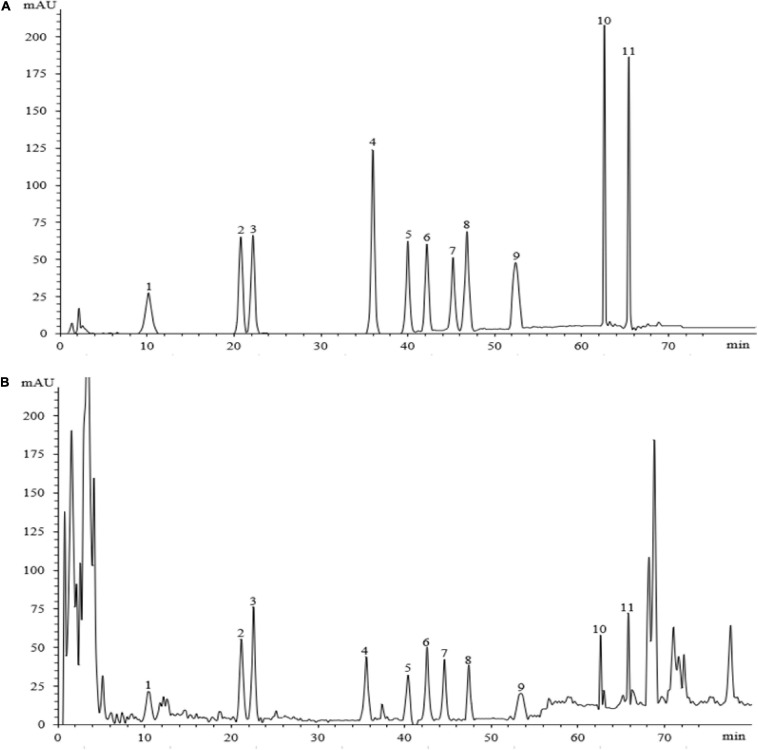
The HPLC chromatograms of the standard and sample. Panel (A) shows the chromatographic peak of the standard substance, panel (B) shows the chromatographic peak of the ginseng root sample. The peaks 1–11 represent ginsenosides-Ro, -Rg1, -Re, -Rf, -Rb1, -Rc, -Rb2, -Rb3, -Rd, -Rh2, and -Rg3.